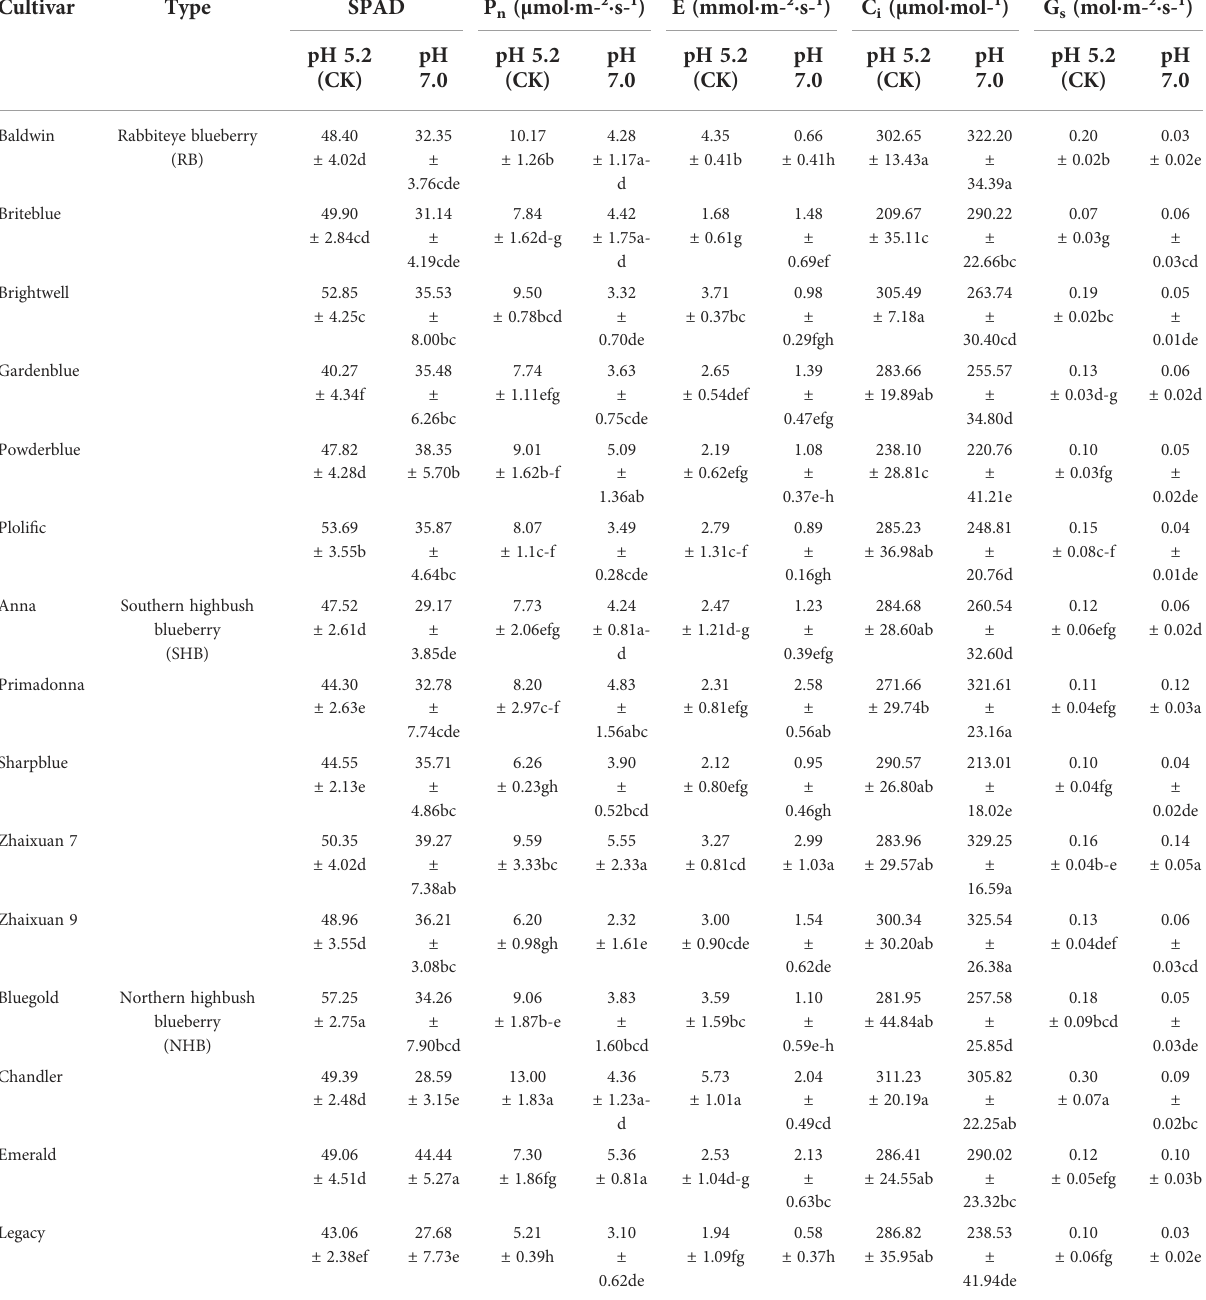
TABLE 2 Effects of high soil pH stress on the leaf photosynthetic physiological characteristics of 15 blueberry seedling cultivars.